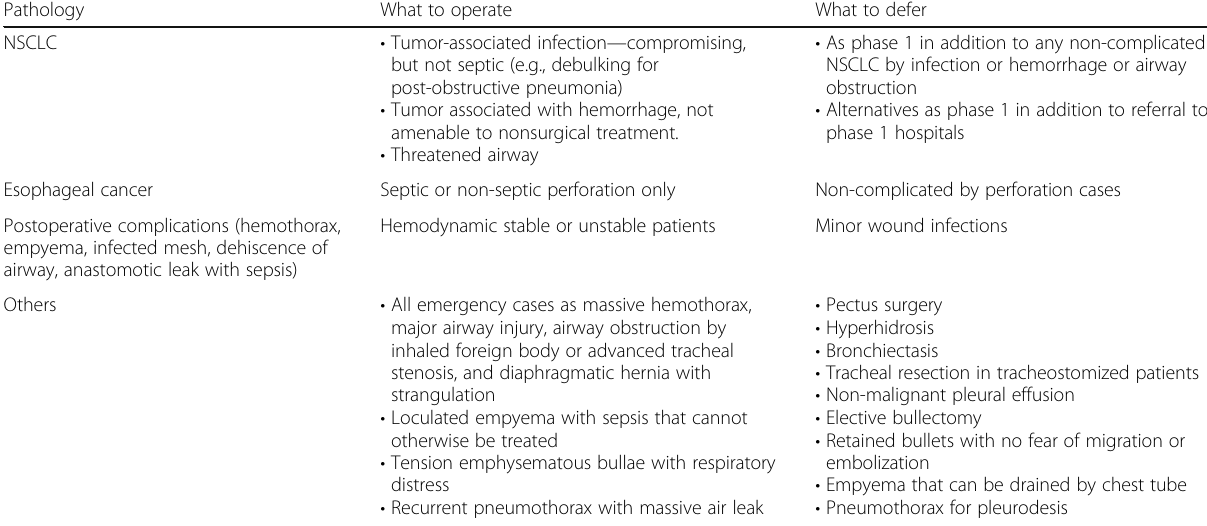
NSCLC non-small cell lung